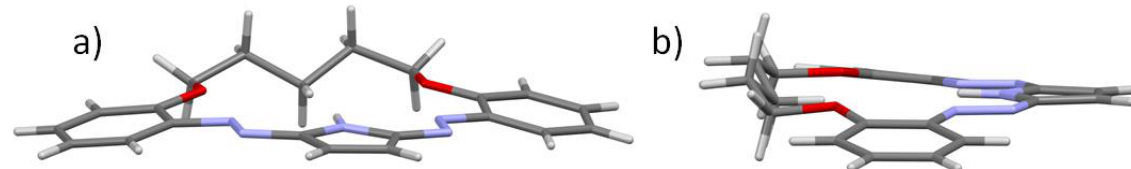
Figure 2. Projections of compound 3 , showing kinked conformation of the molecule: ( a ) front view, ( b ) side view. Subsequent torsions in the linker chain are (ap, sc, -ap, ap, -sc, -ap). More precisely: C10-O1-C11-C12 170.67 (15), O1-C11-C12-C13 57.5 (2), C11-C12-C13-C14 -174.57 (16), C12-C13-C14-C15 179.94 (16), C13-C14-C15-O2 -57.9 (2), C14-C15-O2-C16 -170.87 (16).